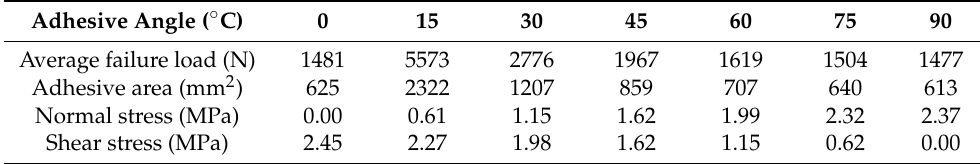
Table 9. Failure strength values of seven groups of adhesive specimens at different angles at 60 ◦ C.